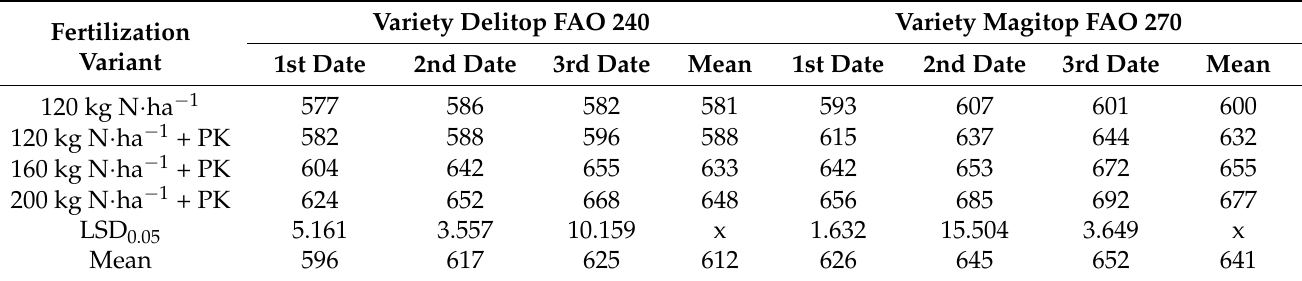
Table 3. The leaf greenness index (SPAD) of maize varieties depending on the fertilization variant in the second year. Fertilization